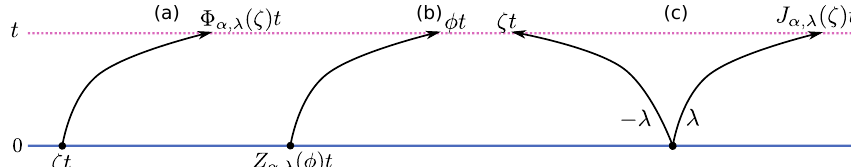
( ζ ) ( cf . (40)), its inverse Figure 3: Pictorial representation of the functions Φ α , λ ( φ ) ( cf . (41)), and of J ( ζ ) ( cf . (63)). In (a) a quasiparticle is produced at Z α α , λ , λ ( ζ ) gives its ray at time t . In (b) Z ( φ ) t time 0 at position ζ t . The function Φ α α , λ , λ is the position at time 0 of the particle that at time t is on the ray φ . In (c) two ( ζ ) quasiparticles with opposite rapidities λ and − λ are created. The function J α , λ gives the ray at time t of the quasiparticle whose partner with rapidity − λ is at ray ζ